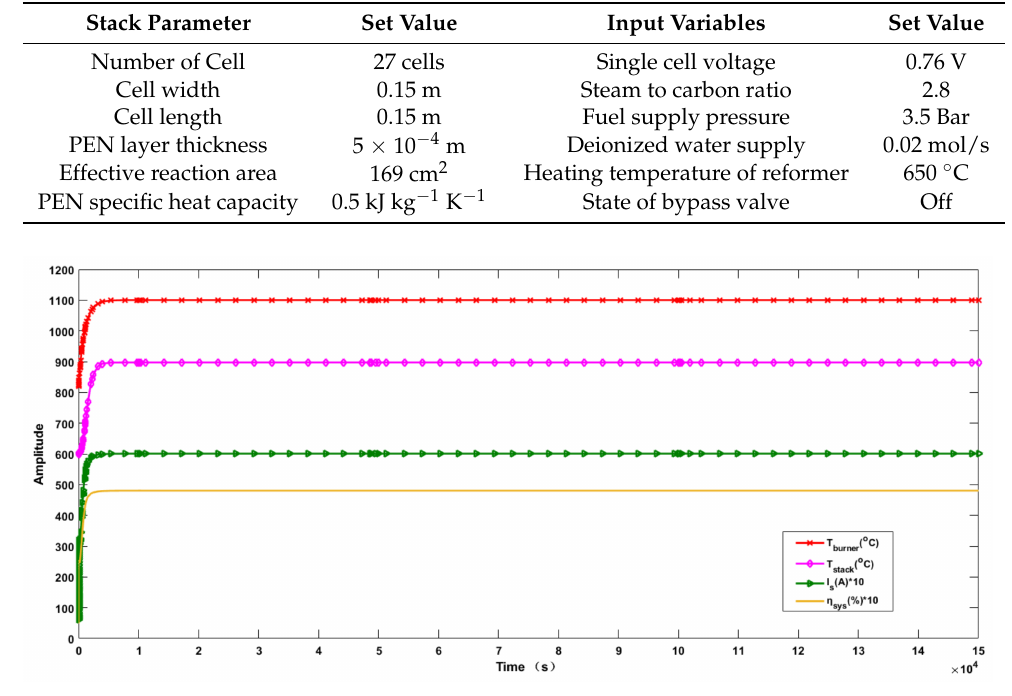
Figure 8. SOFC system main performance parameters under normal